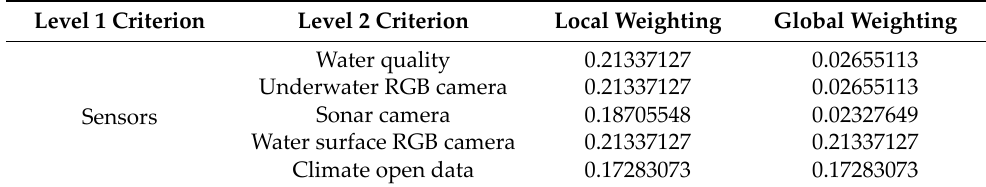
Table 7. Level 2 priority evaluation results for Level 1 ‘sensors’ criterion using the modified AHP.